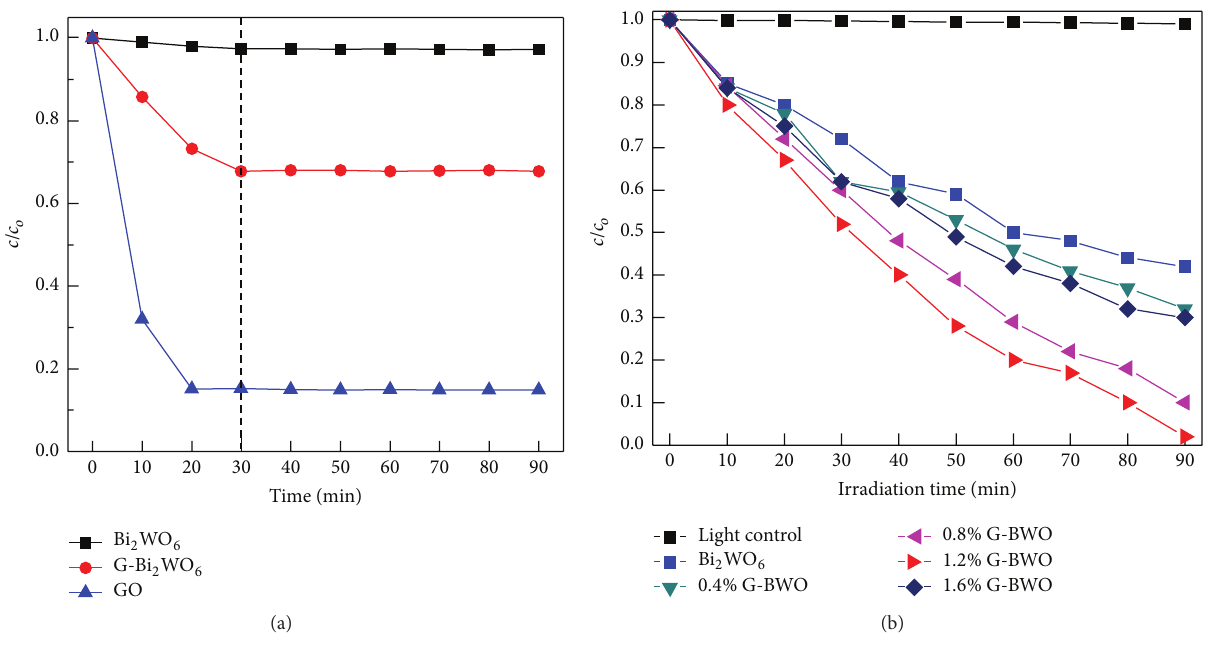
Figure 4: (a) Adsorption capacity of RhB on pure Bi 2 WO 6 , 1.2% G-BWO, and GO. (b) Degradation curves of RhB in the presence of different prepared samples under visible light irradiation (catalysts dosage amount: 1 g/L; c